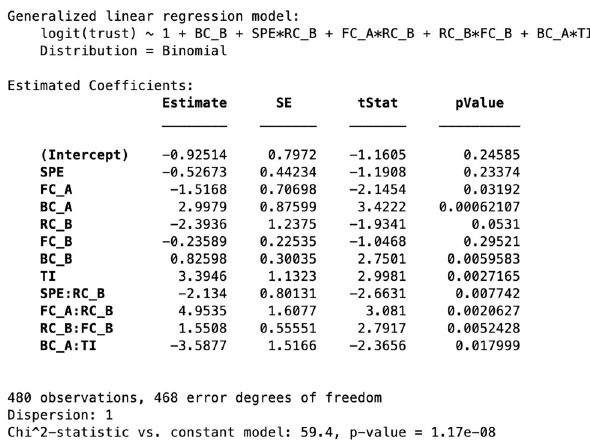
Figure 9: Step - optimized binomial regression. Optimization led to all non - interdependence variables to be dropped except the